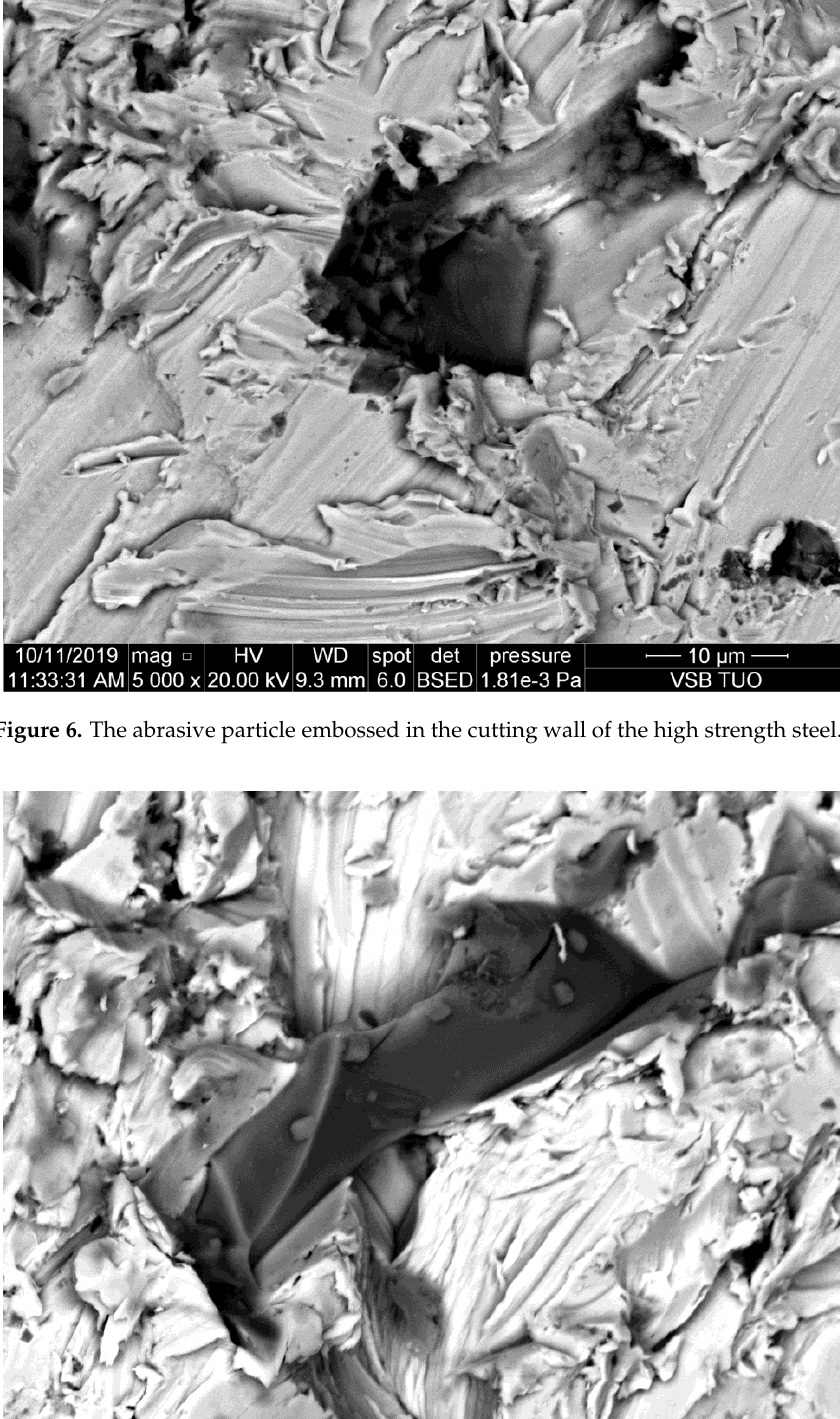
Figure 5. The abrasive particle detected in the cutting wall of the low alloy steel.